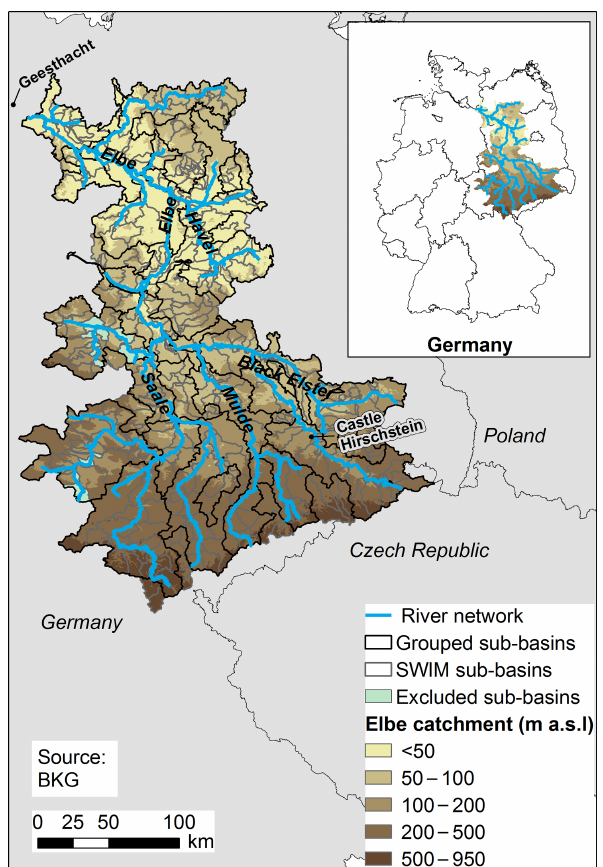
Figure 1. Study area in the Elbe catchment, including the main trib- utaries and sub-basins. The inset shows the location of the catch- ment within Germany. Data sources of figure: BKG